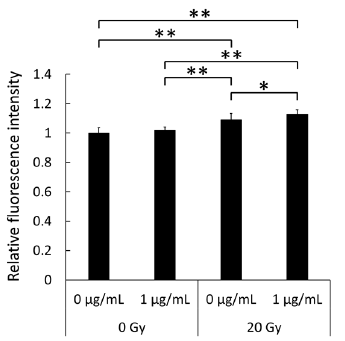
Figure 3. Intracellular levels of peroxynitrite in RAW264 macrophages treated with 0 or 1 µ g/mL lipopolysaccharide (LPS) for 24 h followed by irradiation with 0 Gy or 20 Gy X-rays. Statistical significance was assessed using Tukey’s test. Data are shown as mean ± standard deviation; n = 12. * p < 0.05, ** p <